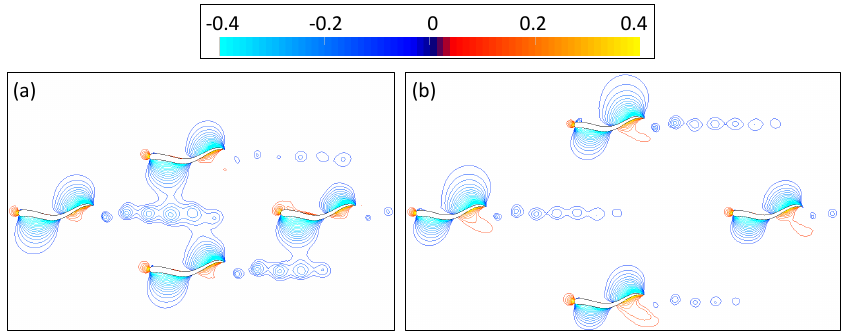
Figure 16. The wake of the diamond swarm: ( a ) spacing = 1.75 L , ( b ) spacing = 1.25 L .